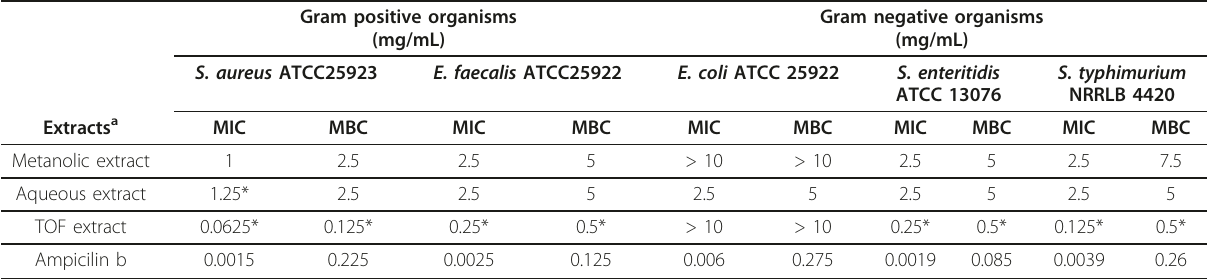
Table 1 Antibacterial activity of Acacia salicina extracts, expressed as Minimum Inhibitory Concentration (MIC) and as Minimum Bactericidal Concentration (MBC)